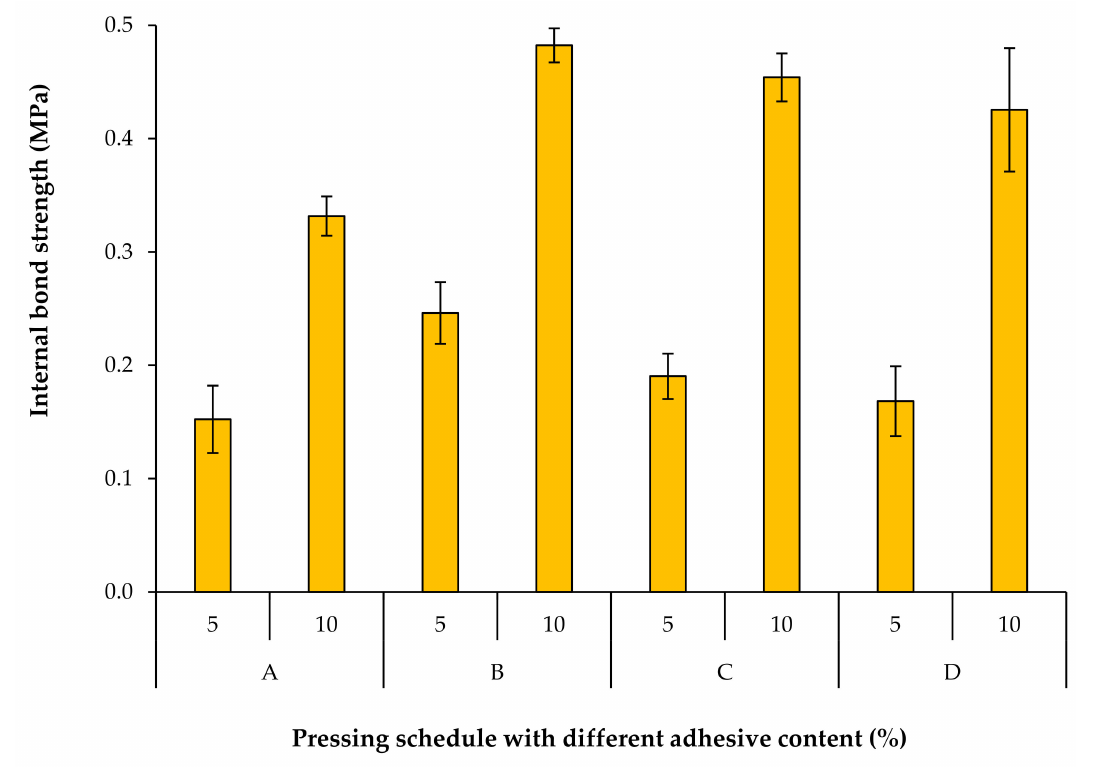
Figure 6. Internal bond of fiberboards produced with different pressing schedules and adhesive